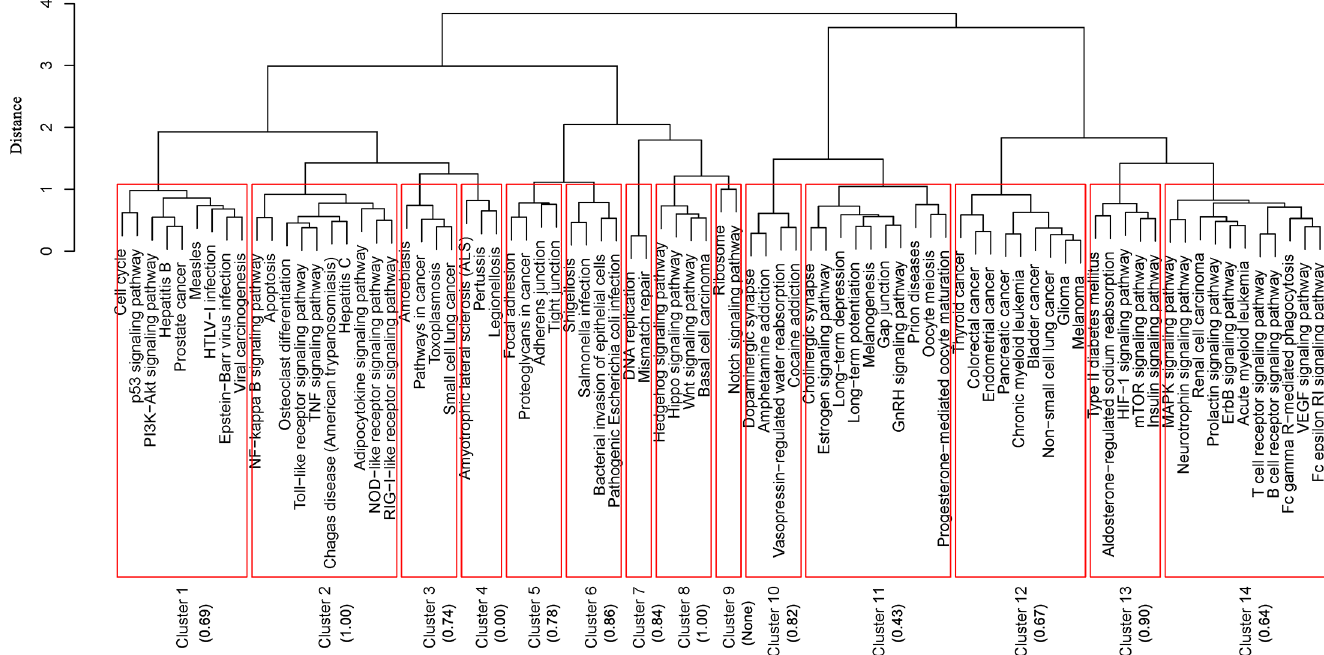
Fig 6. Hierarchical clustering of the enriched pathways. Each cluster is encircled by a rectangle and numbered. Clustering coefficient of common module in each cluster is shown in parentheses. None: represent the fact that there are no common associated genes within the corresponding cluster.